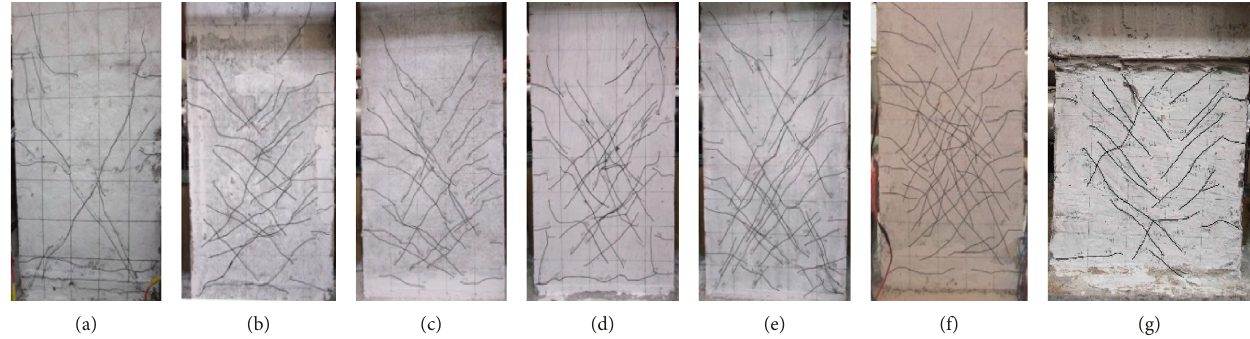
Figure 6: Crack distribution: (a) RC1, (b) HDC2, (c) HDC3, (d) HDC4, (e) HDC5, (f) HDC6, and (g) HDC7.